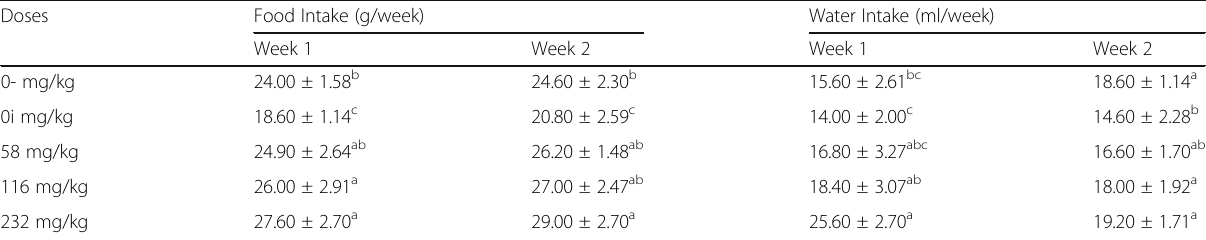
Table 5 Food and water intakes of rats as affected by doses of A. cordifolia leaves extract during treatment